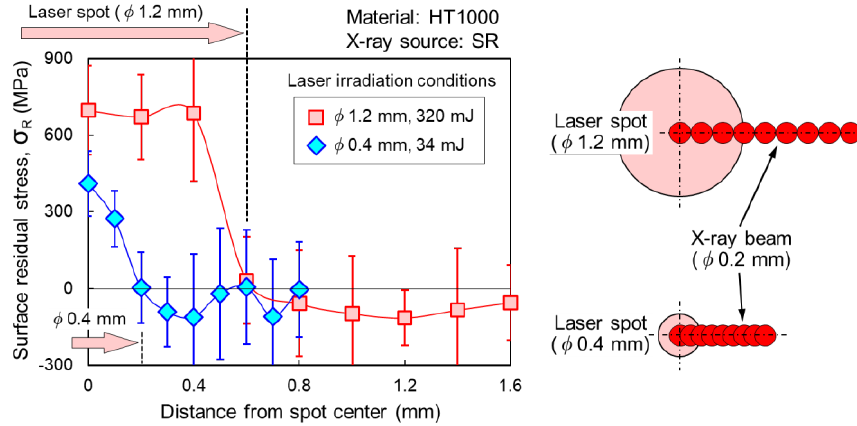
Figure 3. Surface RS profiles across laser spots after single pulse irradiation.